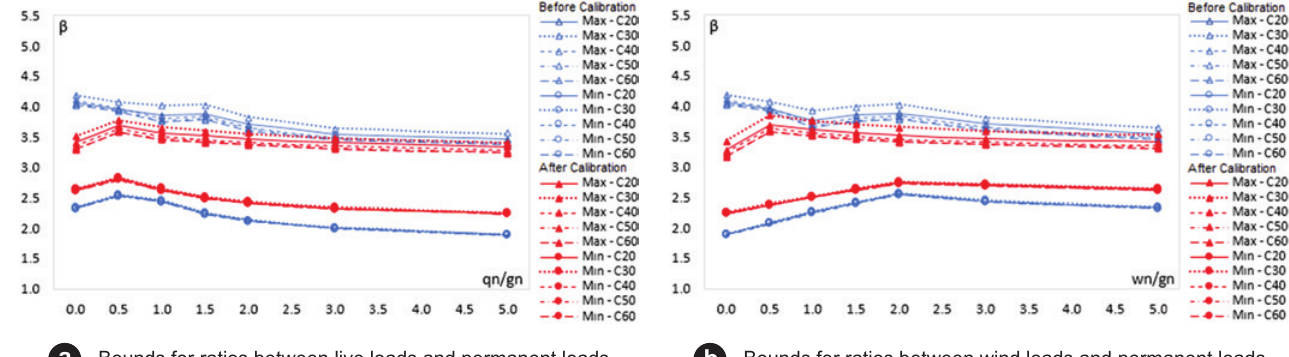
a Bounds for ratios between live loads and permanent loads b Bounds for ratios between wind loads and permanent Figure 3 Reliability index bounds for flexural resistance of reinforced concrete beams, all concrete classes and target = 3.0 β